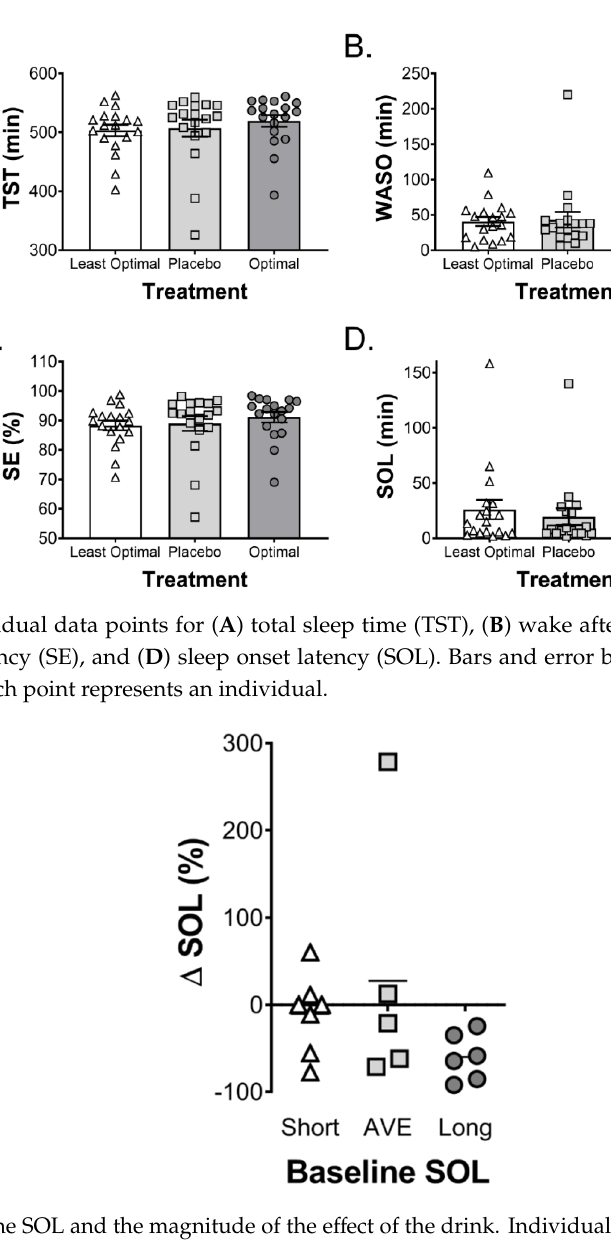
Figure 4. Baseline SOL and the magnitude of the effect of the drink. Individuals with the longest sleep onset latency (SOL) with the placebo treatment (23–140 min) tended to decrease sleep onset more than those with average (AVE; 7–15 min) or short (2–5 min) SOL when given the optimal drink. Lines are means and each dot is an individual.